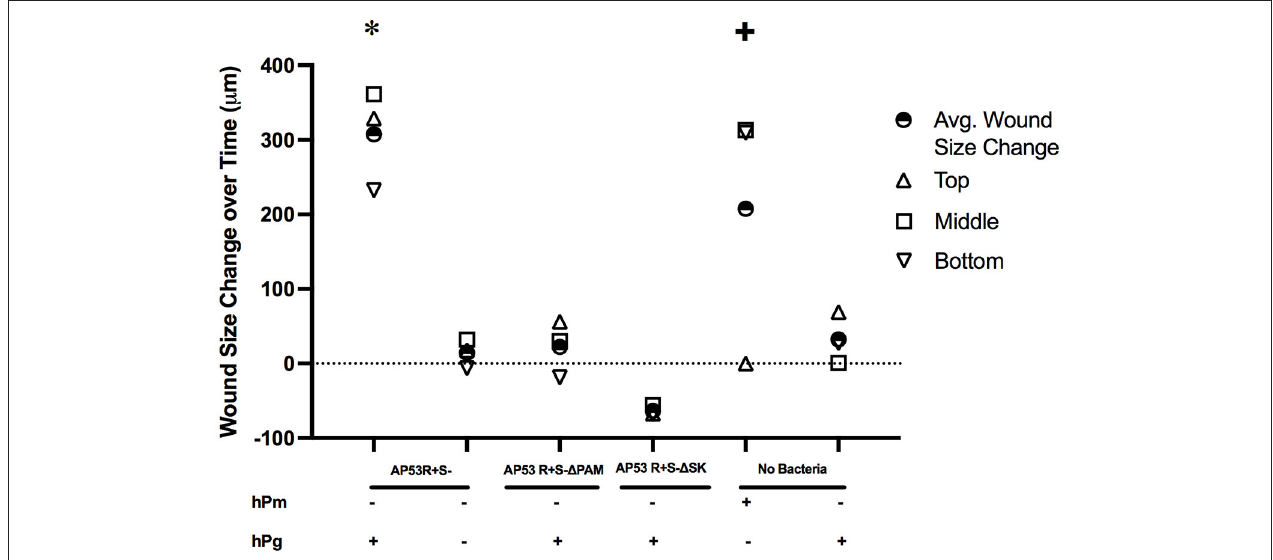
FIGURE 5 | Measurement of keratinocyte wound retraction observed in live imaging by activation of hPg by AP53R + S − and hPm. Wound assay measurements for all treatments were measured as the change in the size of the wound at the initial start of the imaging (time = 0h) to the endpoint (t = 10h for GAS and hPg treatments; t = 2h for hPm). Measurements were made at edges of the wound at the top, middle, and bottom for each wound treatment via ImageJ. Mean wound size changes for each treatment for the three uniform wound locations are calculated and also shown as indicated. The overall p -values were determined by ANOVA ( p < 0.001). The Tukey’s/Holm-Šídák multiple comparisons test were performed to compare each experimental treatment. * indicates statistical significance ( p < 0.05) of AP53R + S − and hPg compared to all of the other treatments. + indicates statistical significance ( p < 0.05) of hPm compared to AP53R + S − 1 SK and hPg.